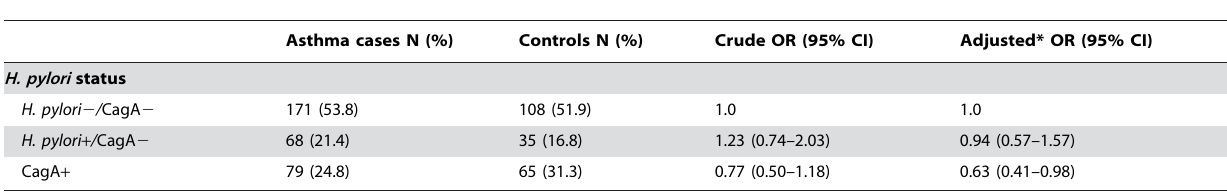
Table 2. Association between H. pylori serostatus and asthma in asthma cases (N =318) and non-asthma controls (N =208).